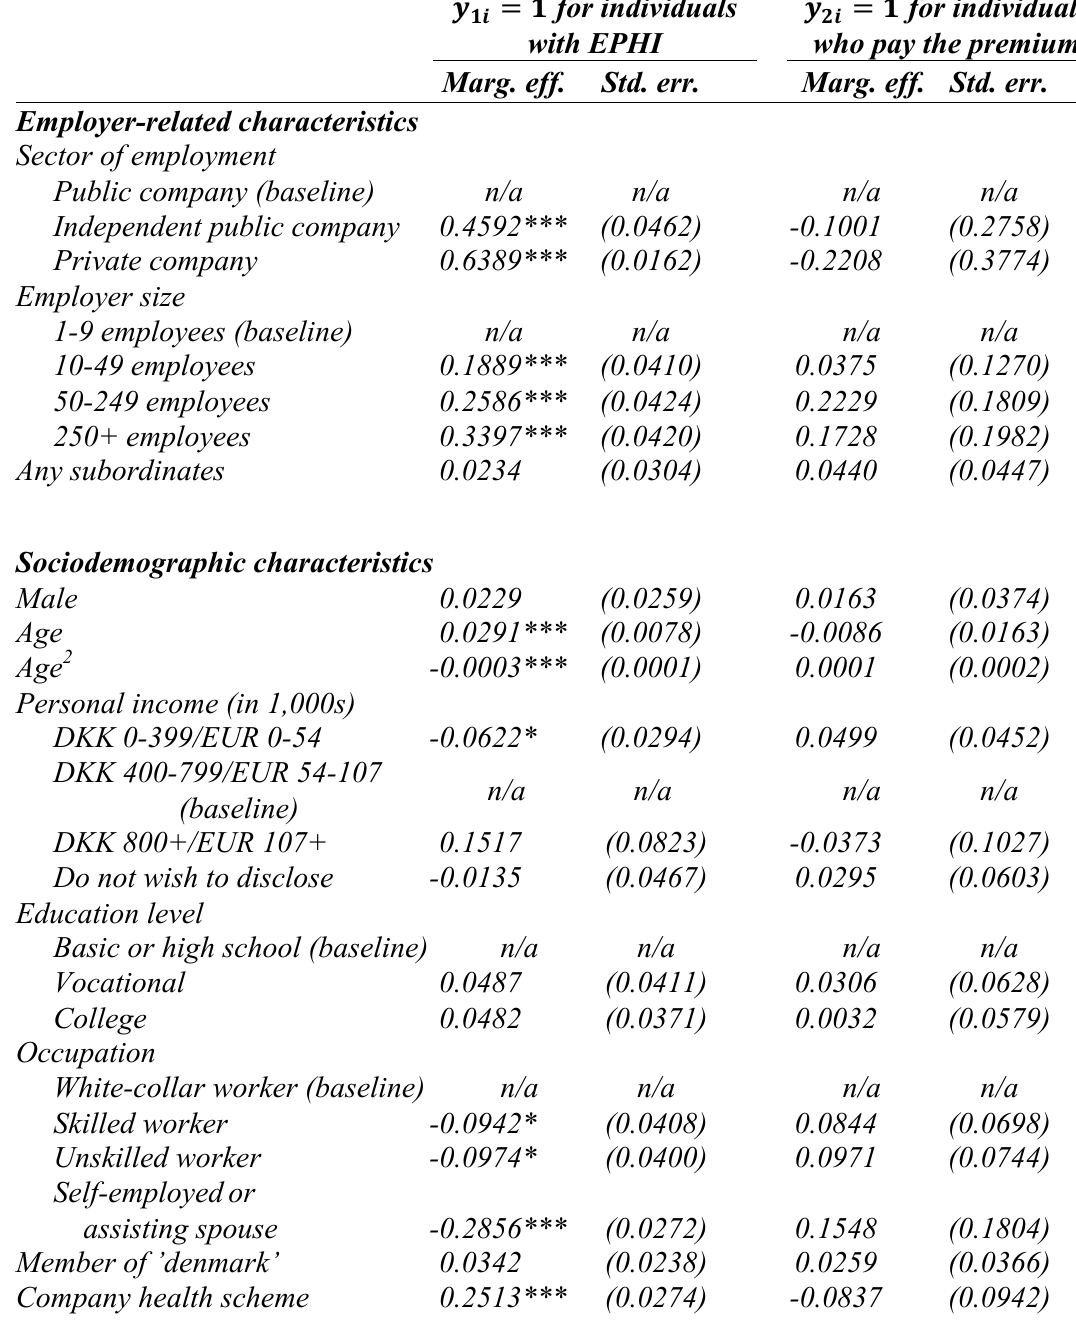
Marginal effects from bivariate probit model with sample